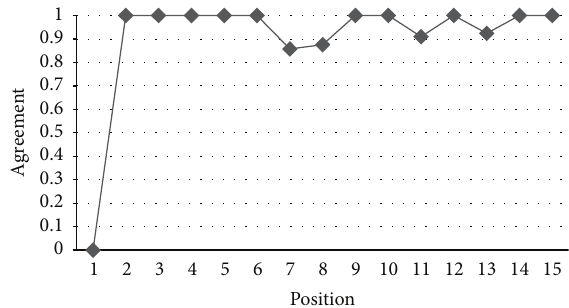
Figure 11: Agreement between the IPA and HAM rankings of functional requirements.